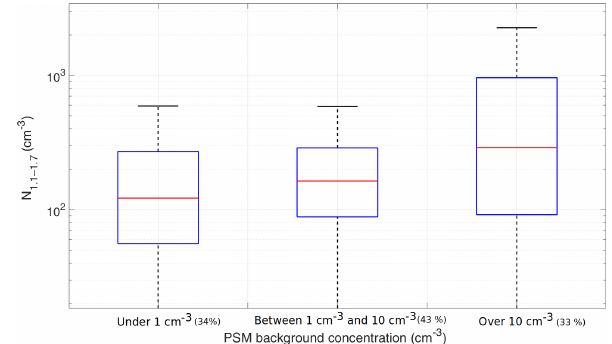
Figure 1. The fraction of scans discarded during data quality check plotted against the daily medians of PSM background concentra- tion. The color of the circles shows the ambient relative humidity (RH).